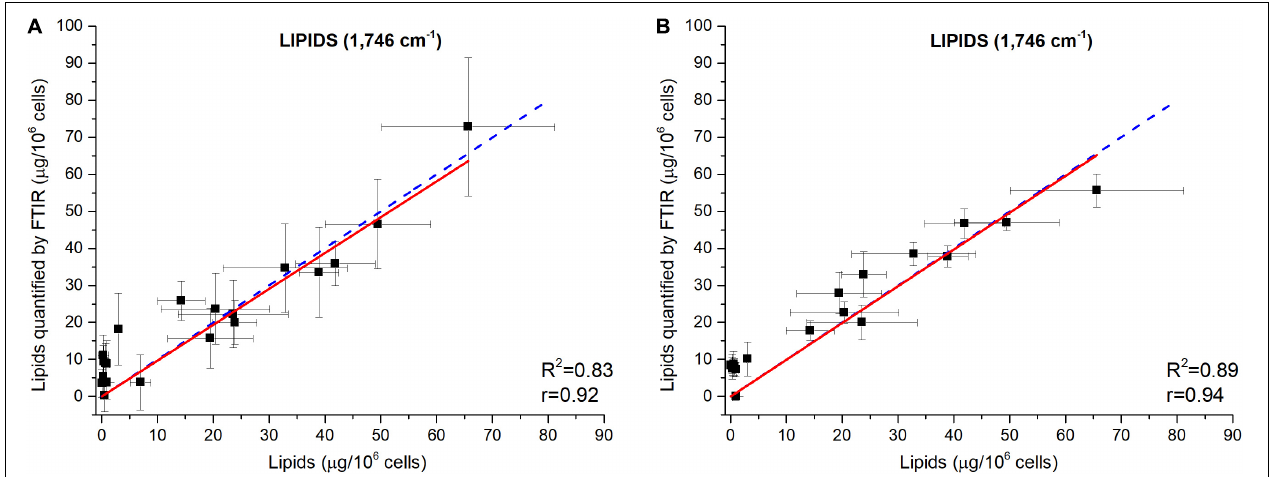
FIGURE 5 | Validation of the FTIR methodology using data from a N-starvation experiment conducted in a photobioreactor (Scarsini, 2021). Correlations between lipids quantified from FTIR absorbance measured at 1,746 cm – 1 and lipids concentrations quantified by fluorescence after Nile Red staining considering (A) baseline-corrected spectra and (B) baseline-corrected and normalized spectra. Two million cells were deposited on the silica plate. Adjusted R 2 and Pearson’s correlation coefficients of the linear regression curves (r) are indicated on the graphs.